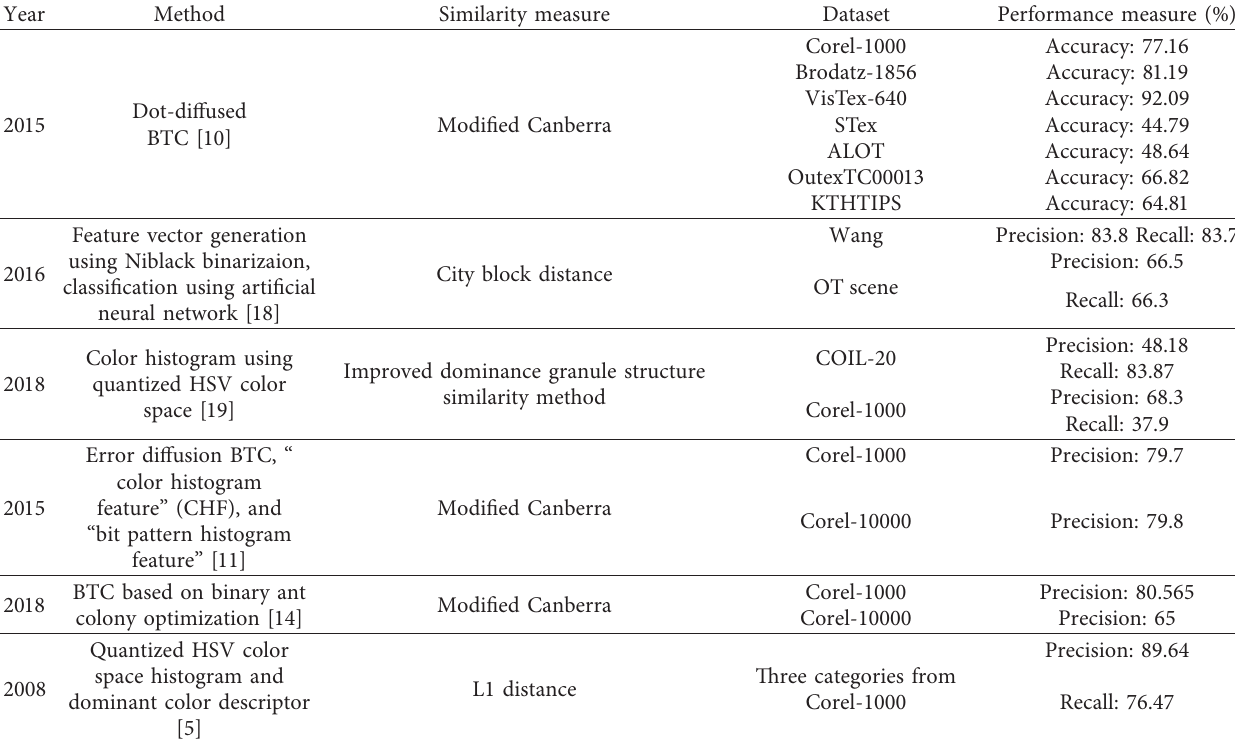
Table 1: Summary of color feature-based image retrieval